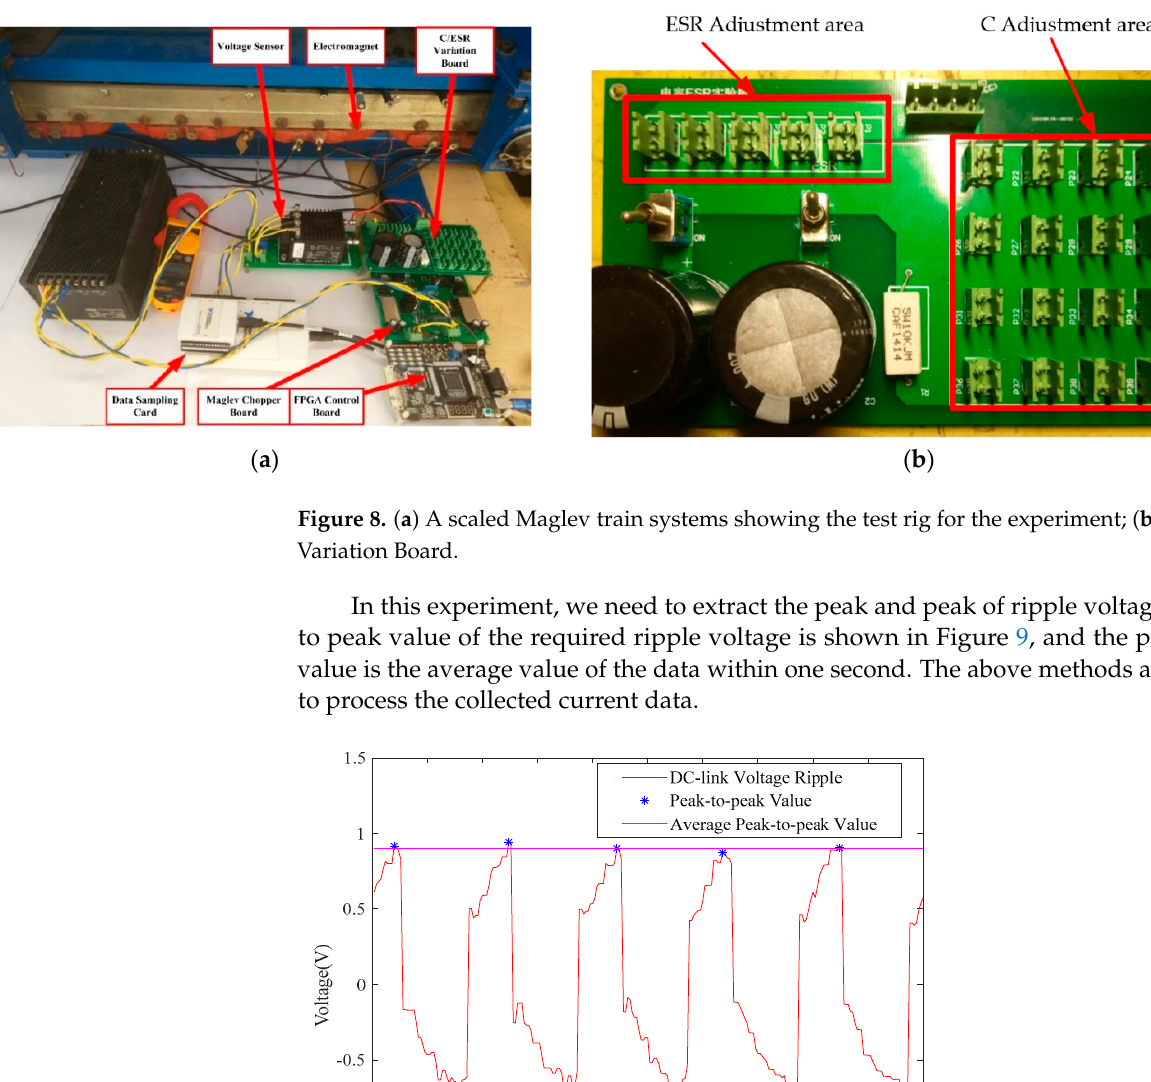
Figure 8. ( a ) A scaled Maglev train systems showing the test rig for the experiment ; ( b ) The C/ESR Variation Board